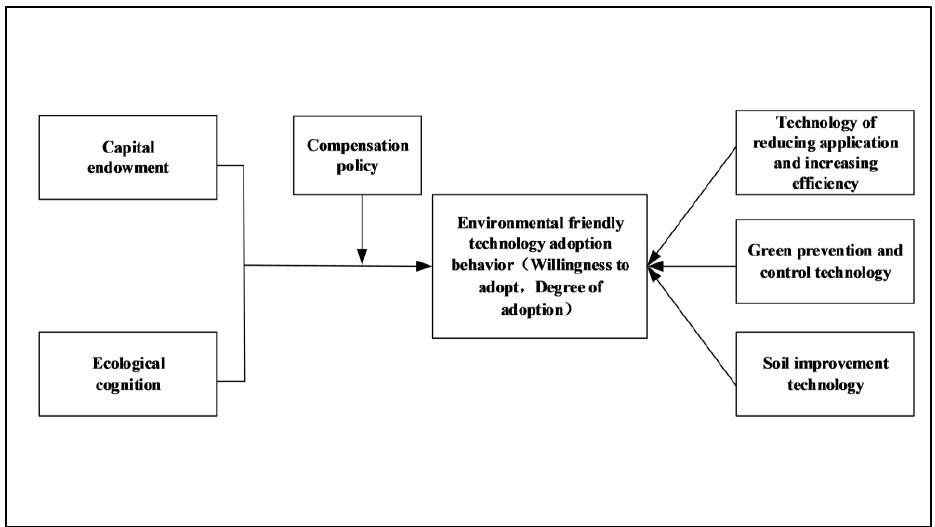
Figure 1. Theoretical model for the adoption of environment-friendly technology by farmers. Here, capital endowment and ecological cognition have been set as independent variables and “willing- ness to adopt” and “adoption” as dependent variables. In addition, compensation policy is com- posed of moderating